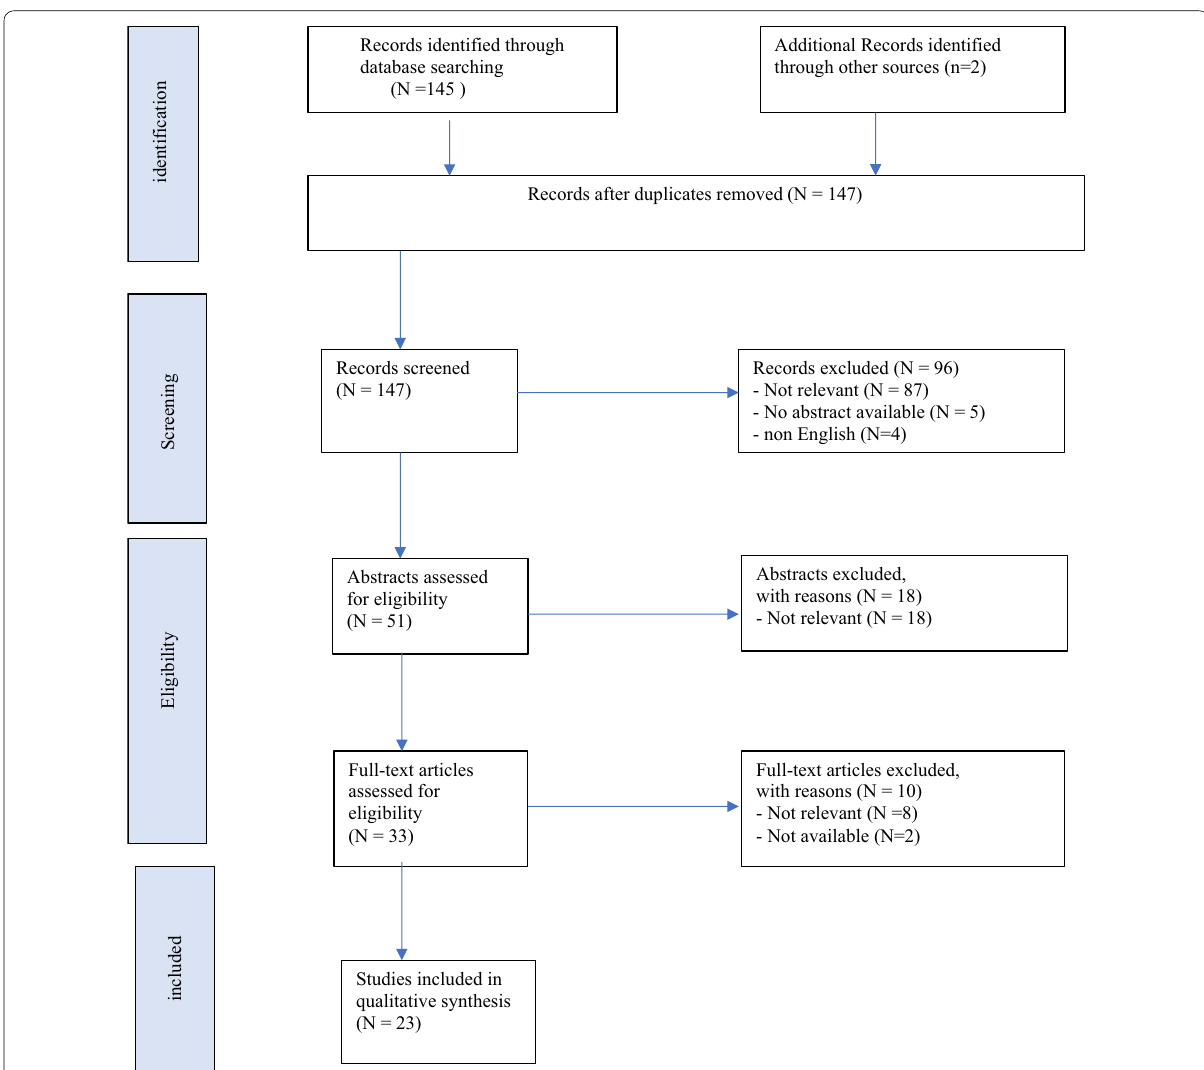
Fig. 3 Preferred Reporting Items for Systematic Reviews and Meta-Analyses (PRISMA) flow diagram depicting the evidence synthesis for the literature review on management of ureteric avulsion during